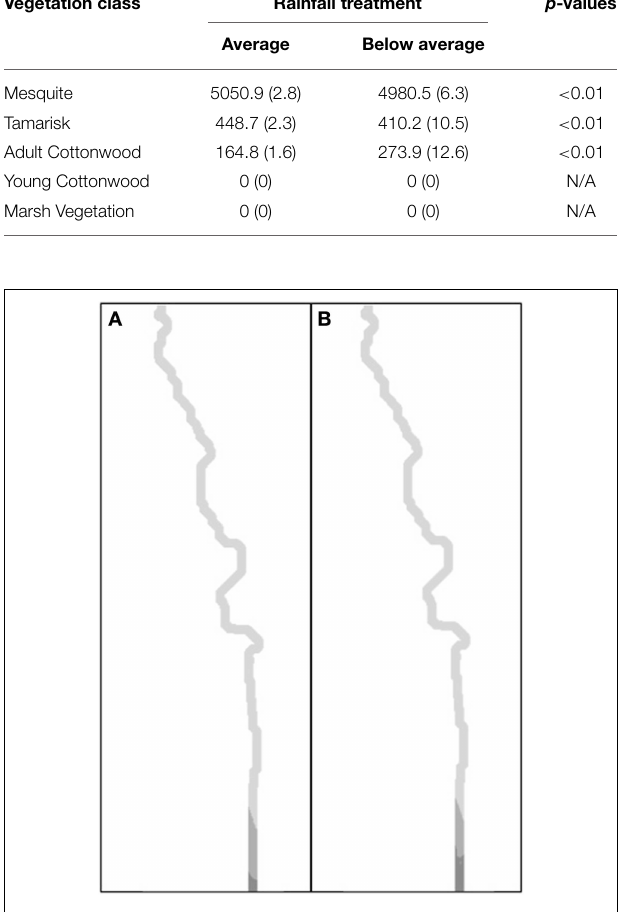
FIGURE 4 | Spatial distribution of riparian vegetation classes, Mesquite (light grey), Tamarisk (medium grey), and Old Cottonwood (dark grey), along the Rio San Miguel for average (A) and below average (B) rainfall treatments.